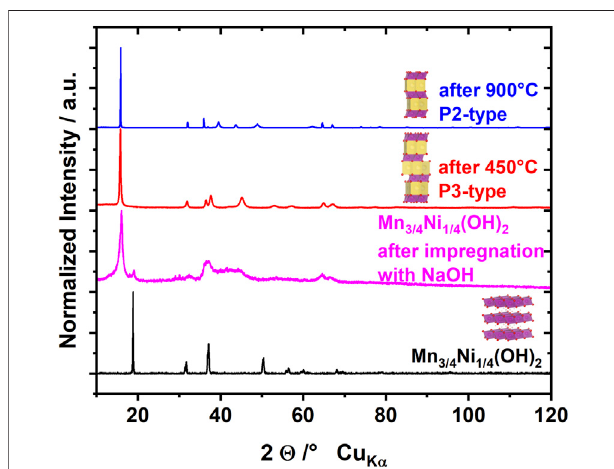
FIGURE 3 | Ex-situ powder XRD patterns of the fresh hydroxide precursor(black),thedryimpregnatedpowder,thepowderaftercalcinationat 450 ° C in air and the phase pure P2 material after 900 ° C in